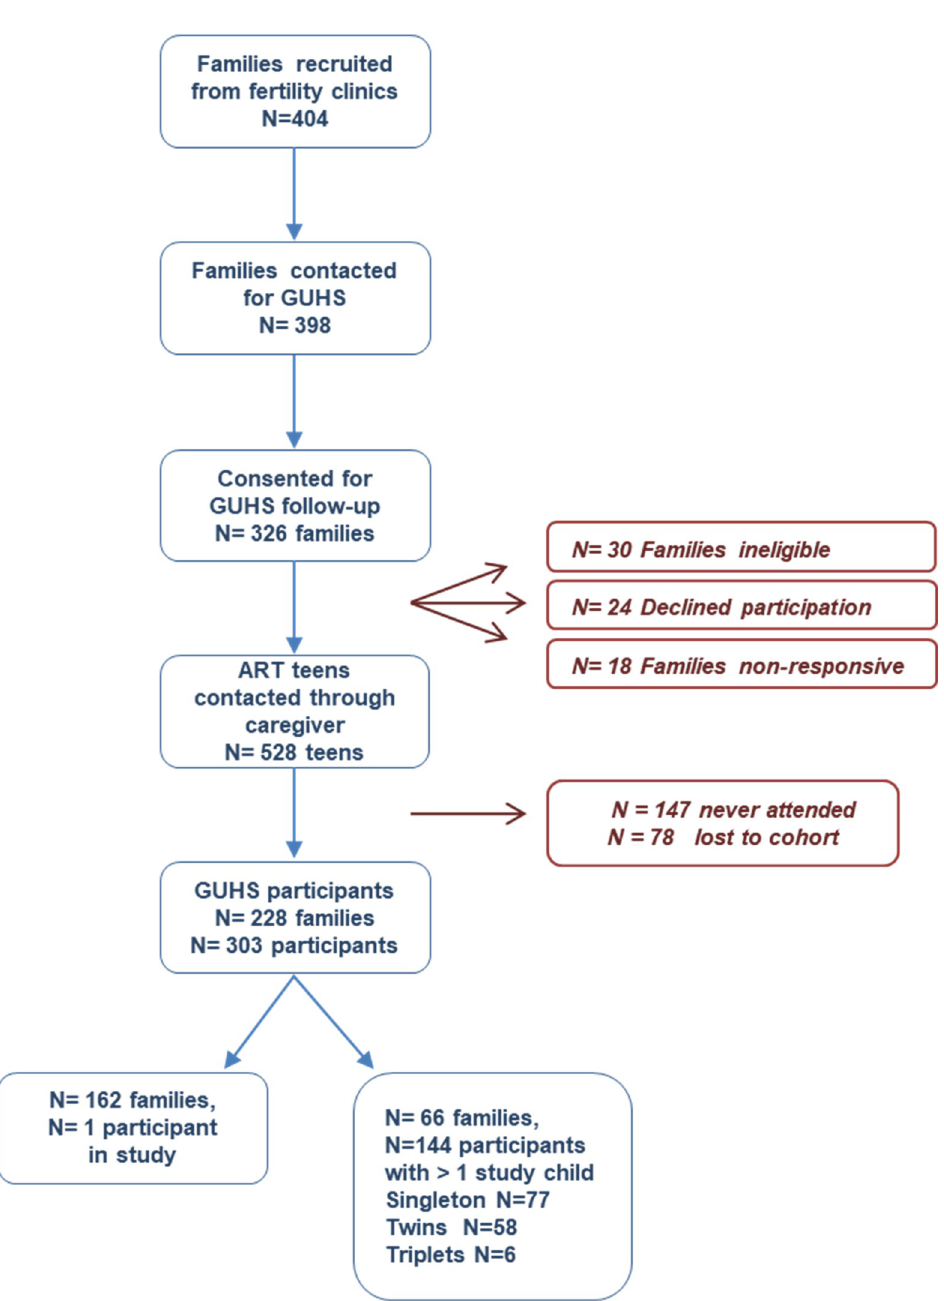
Fig 1. Flowchart of study recruitment process. ART: Assisted reproductive technologies; GUHS: Growing Up Healthy Study.